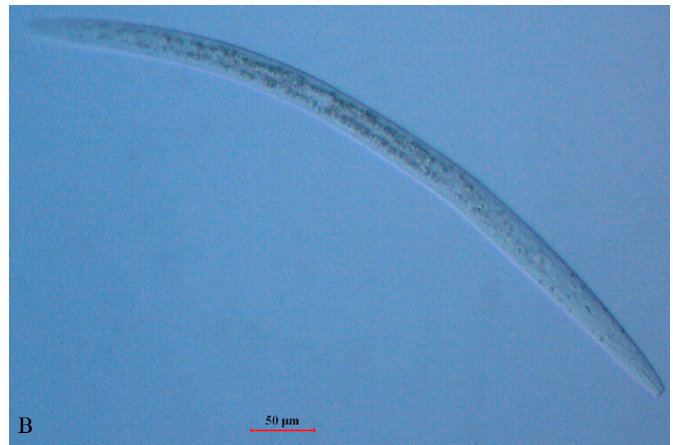
Figure 1. The phenotype of B. xylophilus after soaking in doble distilled water (ddH 2 O) ( A ) and control solution ( B ) for 48 h. Scale bars = 50 μ m.